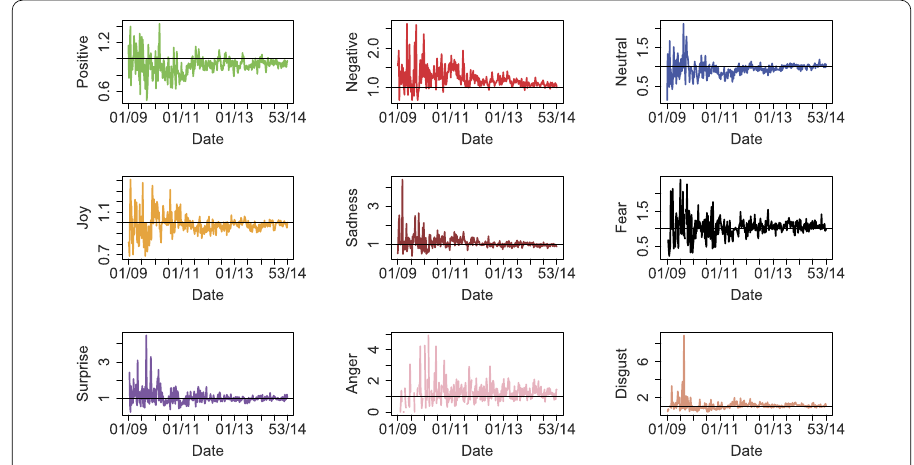
Figure 2 Emotion and sentiment military-to-control ratios over time. Sentiment ratios are estimated for three opinion types: positive , negative , and neutral and emotion ratios are estimated for six Ekman’s emotions: joy , sadness , fear , surprise , anger , and disgust over the period from 01/2009 to 12/2014 for an example Twitter set p 12 . The set of military and control users is the same over